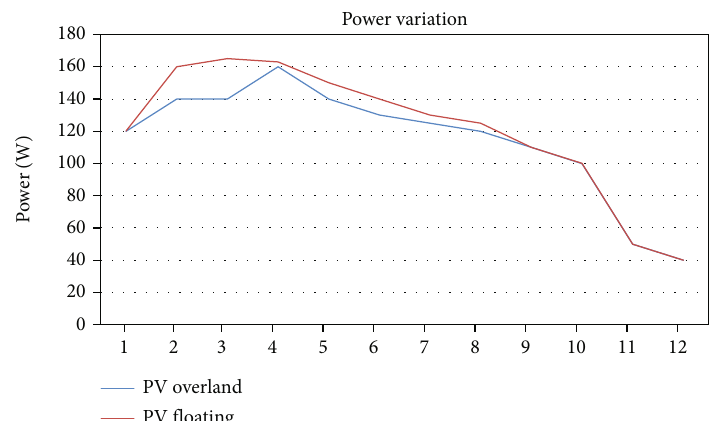
Figure 8: Comparison of